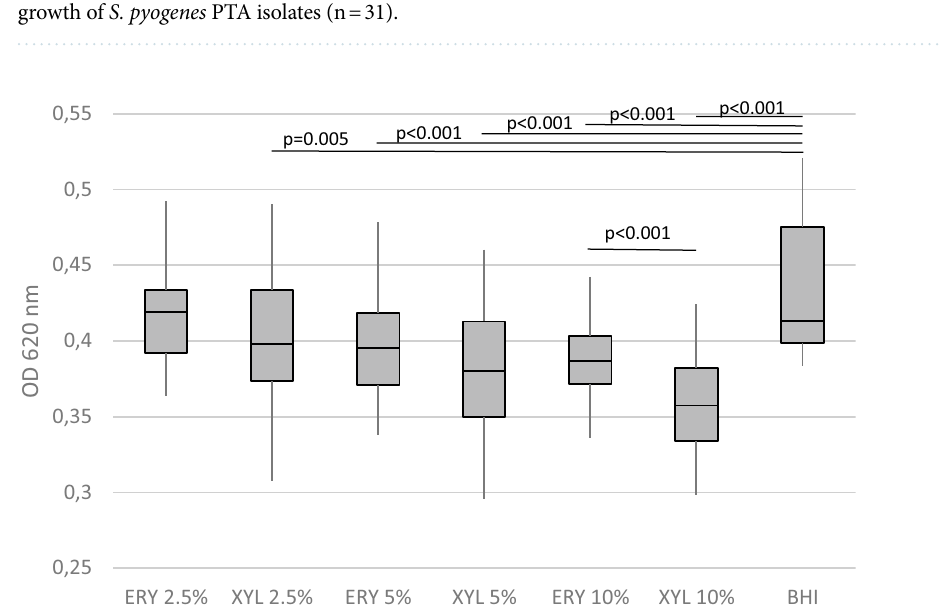
Figure 2. The growth of 31 S. pyogenes isolates from PTA pus in the presence of ERY erythritol, XYL xylitol and BHI brain heart infusion. Minimal, maximal, median, 25 percentile and 75 percentile values of optical density are